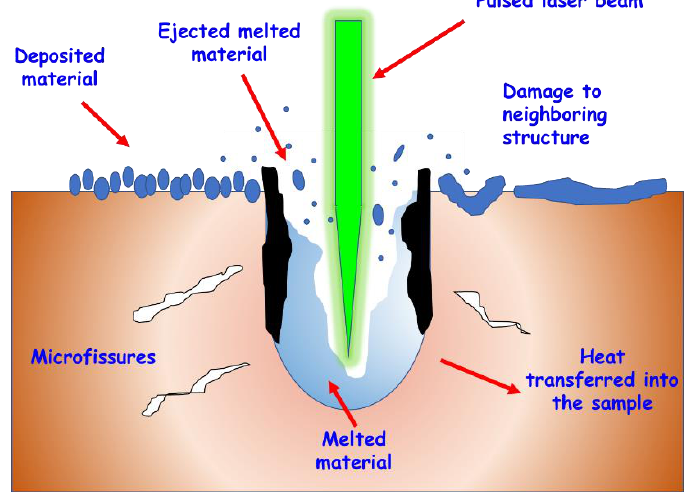
Figure 1. Ablation process observed during laser irradiation.